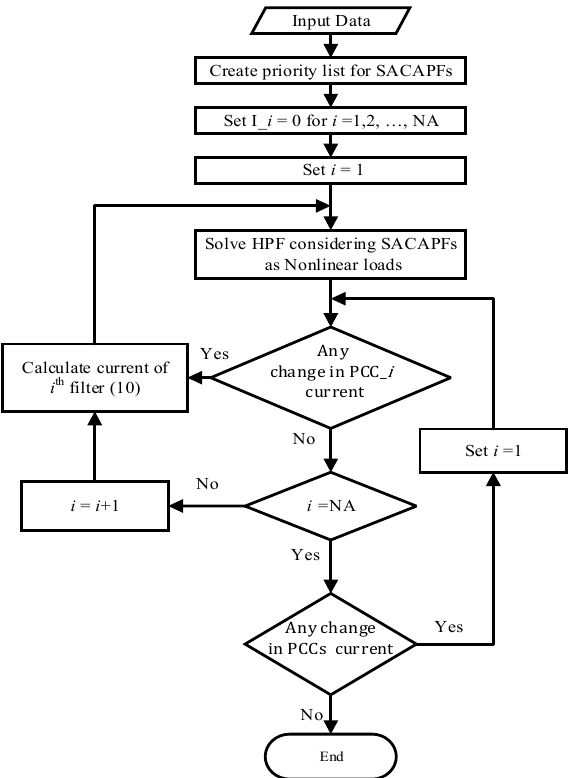
Figure 4. Flowchart of the proposed method for modeling operation of multiple SACAPFs in radial distribution networks (NA: Number of SACAPFs).